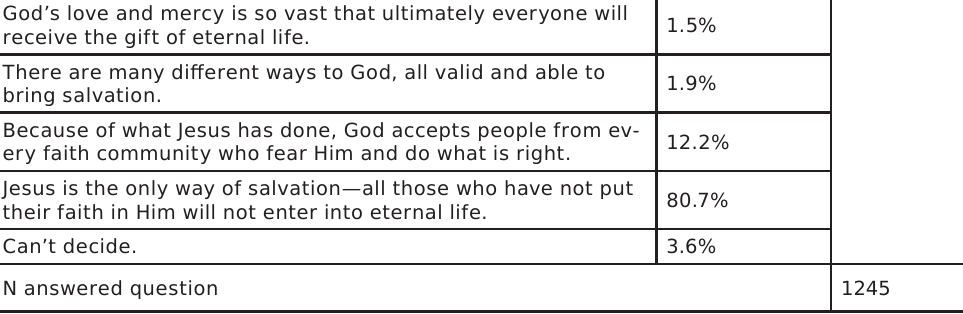
“Which of the following comes closest to your view of Christianity and other religions? Please select one